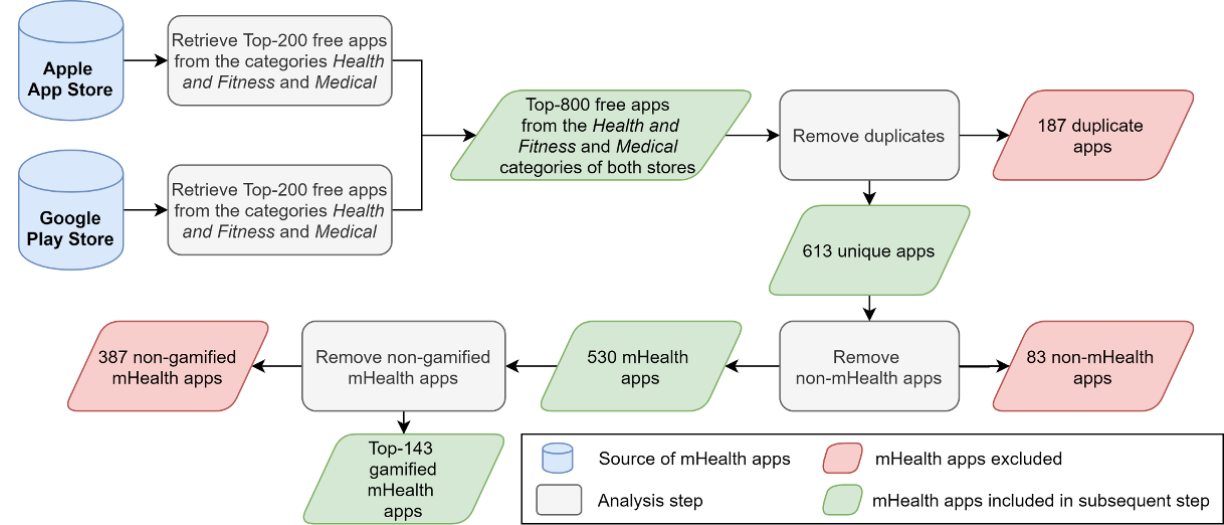
Figure 2. Setting up a database of pertinent gamified mHealth